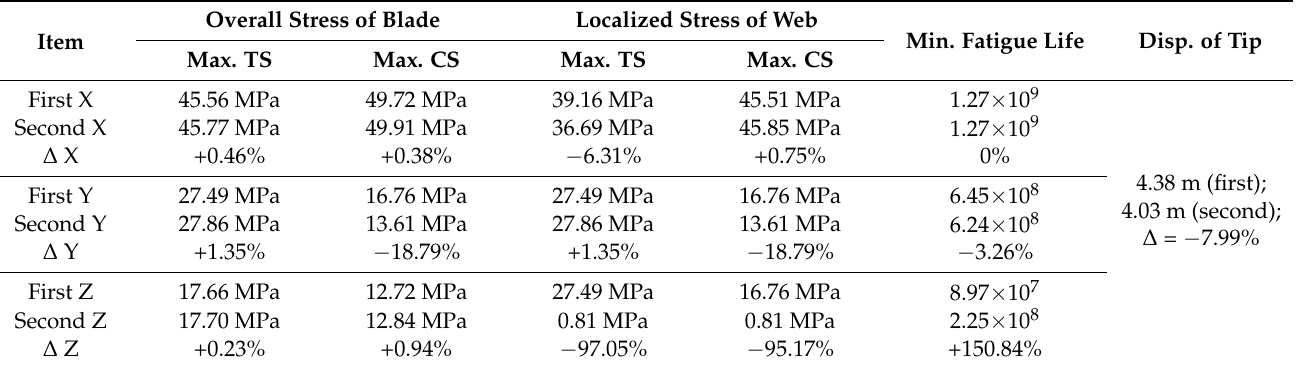
Table 6. Compared results of performance indexes between the first and second generation wind turbine blades in the DLC-1 case.